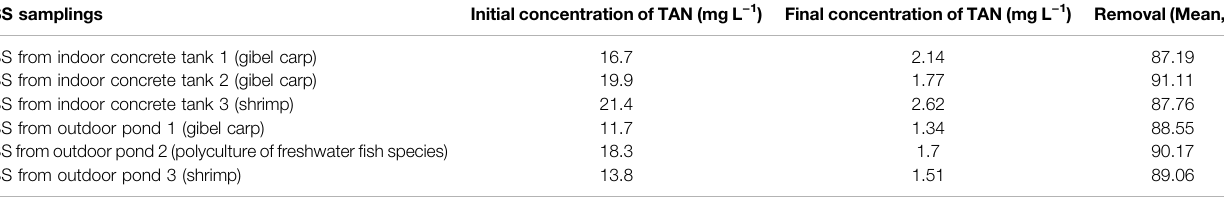
TABLE 2 | Effect of the PHB-enriched treatment on total ammonia nitrogen (TAN) removal rate from suspended solids (SS). SS